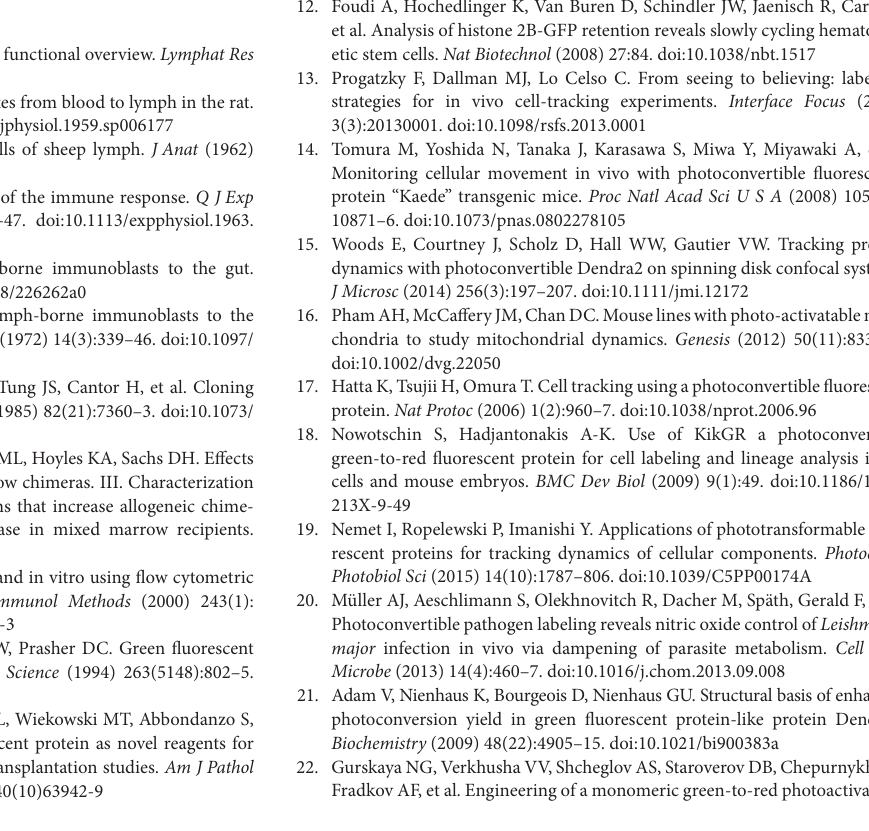
FIGUrE s1 | Scheme displaying the collection of blood from the vena cava. After ventral opening of the mouse, the intestines were laid to the right and the vena cava was exposed. A 30 G syringe containing 200 µl of lysis buffer was inserted at the junction of the left renal vein with the inferior vena cava and blood is slowly collected from the vessel. FIGUrE s2 | Comparison of donor T cell yield from EDTA wash fraction and subsequent enzymatic digestion of the tissue. (A) Representative flow cytometry plots showing the percentage of donor cells within live single lymphocyte population. All donor cells in the intestine are washed out by the extensive washing steps (left), and no T cells are found after digesting the remaining tissue (right). (b) Quantification of donor T cells in the two fractions. FIGUrE s3 | Exemplary flow cytometry gating scheme to identify the percentage of photoconverted cells among live donor lymphocytes. From left to right: lymphocytes are gated by size and granularity, live cells are gated negative for dead stain, and single cells were selected by plotting height and area of the forward scatter. Donor cells were identified by being positive for the green and/or the red fluorescent Dendra2 protein, and percentages of cells with red Dendra2 fluorescence were quantified within this